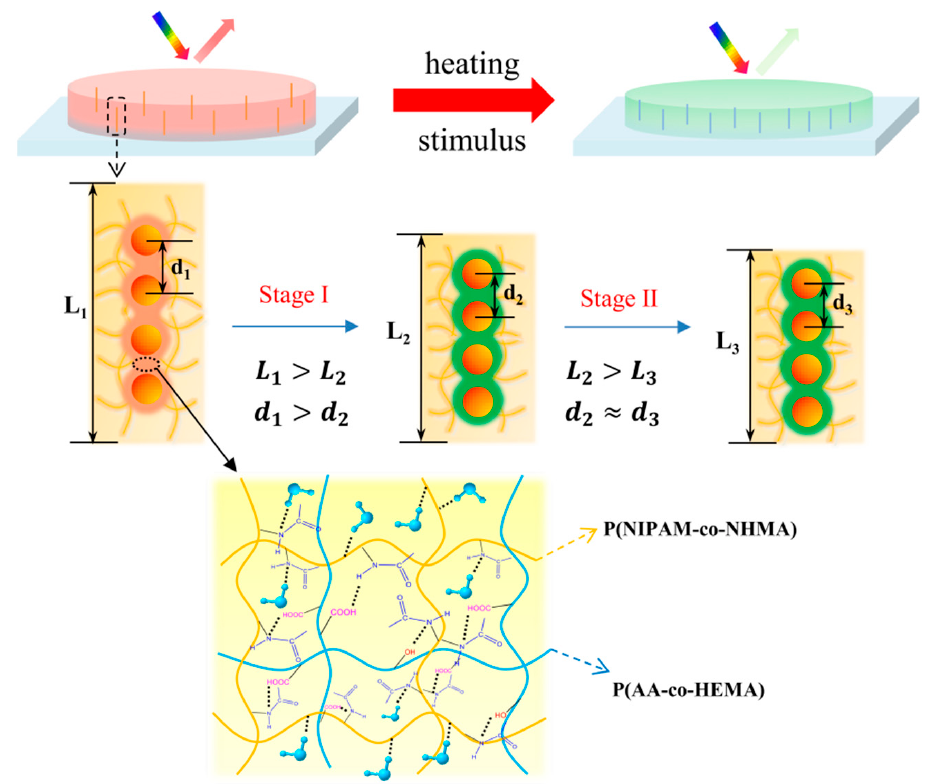
Figure 3. A schematic illustration of the thermochromic mechanism of TRPCF-PNC: The P(NIPAM- co-NHMA) hydrogel matrix had a larger deformation in the thickness direction than the embedded PNCs. The magnified area shows that the interpenetrating network formed in the hydrogel of the PNCs after polymerization, which endowed them with a thermos-responsiveness to the PNCs.